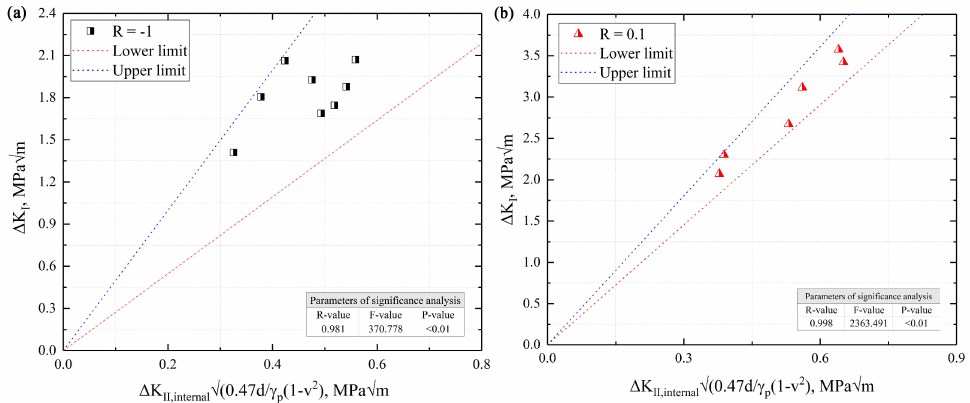
Figure 17. The 90% prediction interval about Equation (15) of internal-induced fracture at R = − 1 and 0.1. ( a ) the statistical analysis of the interior-induced for R = –1; ( b ) the statistical analysis of the interior-induced for R =